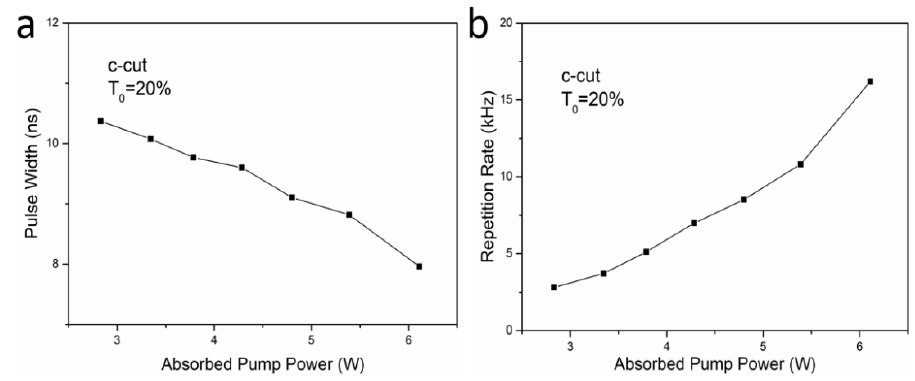
Figure 8. Pulse width ( a ) and repetition rate ( b ) versus the absorbed pump power for the passively Q-switched Nd:ASL laser.